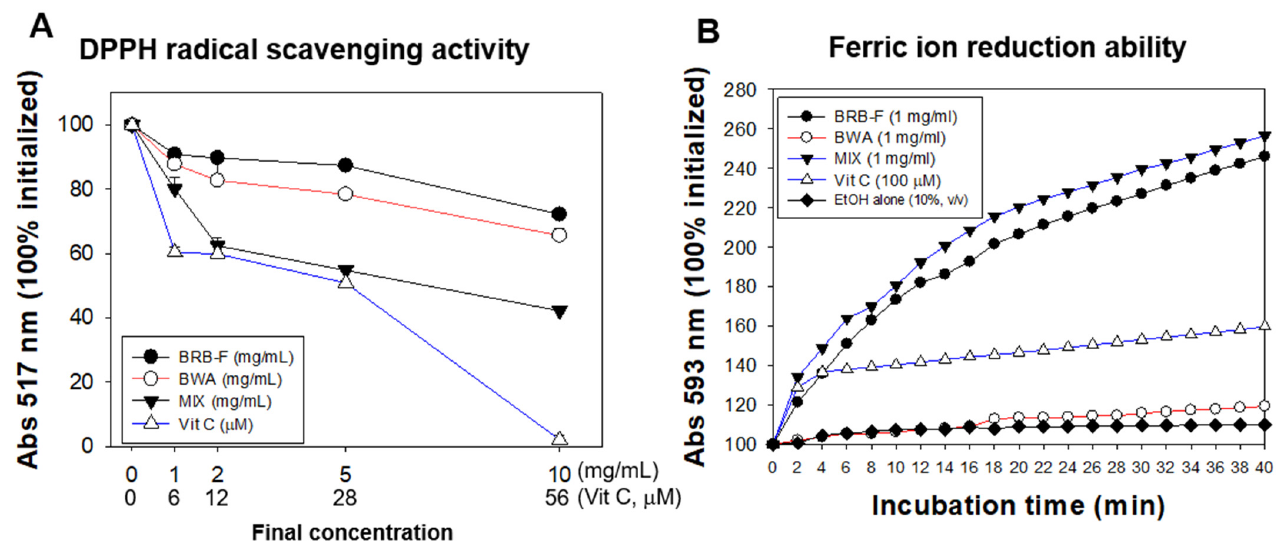
Figure 1. Antioxidant ability of BRB-F, BWA, and MIX in comparison with vitamin C (Vit-C). ( A ) DPPH-radical-scavenging activity. ( B ) Ferric-ion-reduction ability; BRB-F, fermented black rice bran; BWA, beeswax alcohol; MIX, 1 mg/mL mixture of BWA and BRB-F (1:6, w / w ); DPPH, 2,2- diphenyl-1-picrylhydrazyl.